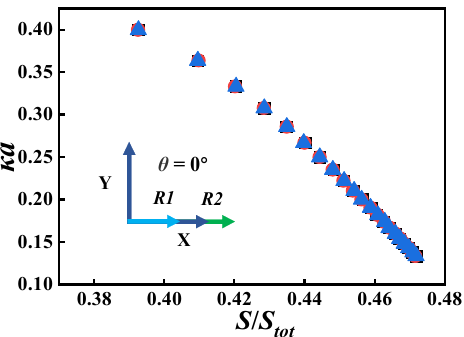
Figure 3. The calculation results for three different area ratios at θ = 0° .